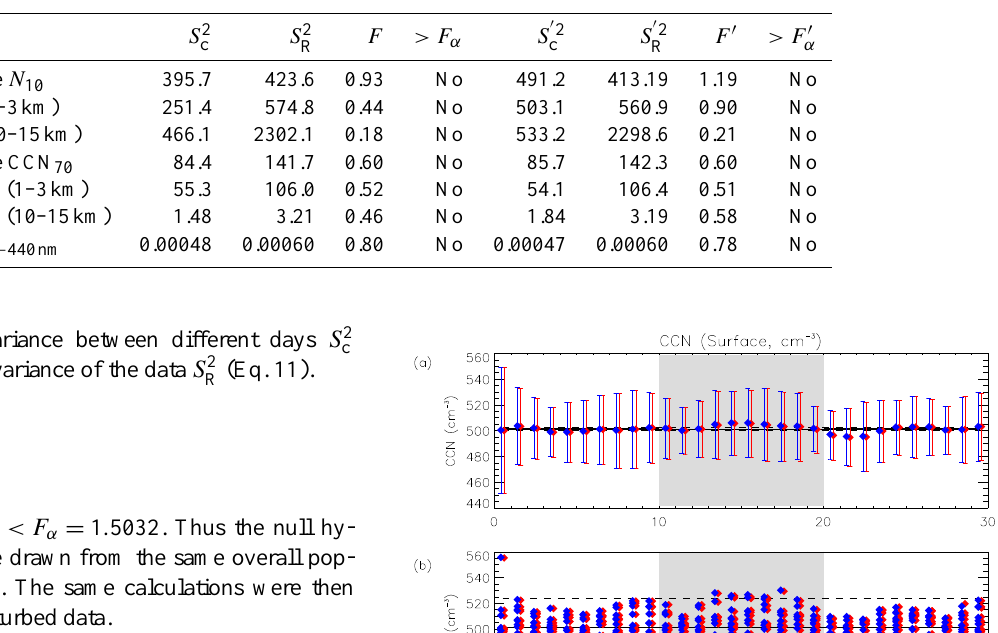
Table 2. Results of F-tests on N 10 , CCN 70 and ˚Angstr¨om exponent. CCN 70 at 10–15km and ˚Angstr¨om exponent are included for reference, but were found not to be normally distributed. F α = 1 . 5020. Symbols with primes refer to perturbed data.